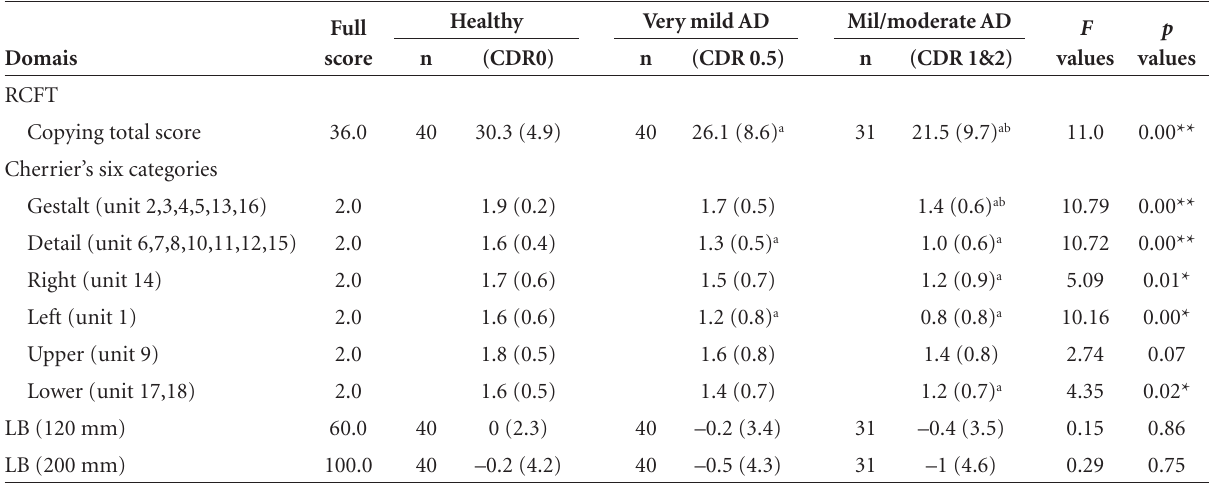
Table 2. The scores for RCFT copying, the LB and Cherrier’s six categories classification of groups of healthy, very mild AD, and mild/ moderate AD subjects.